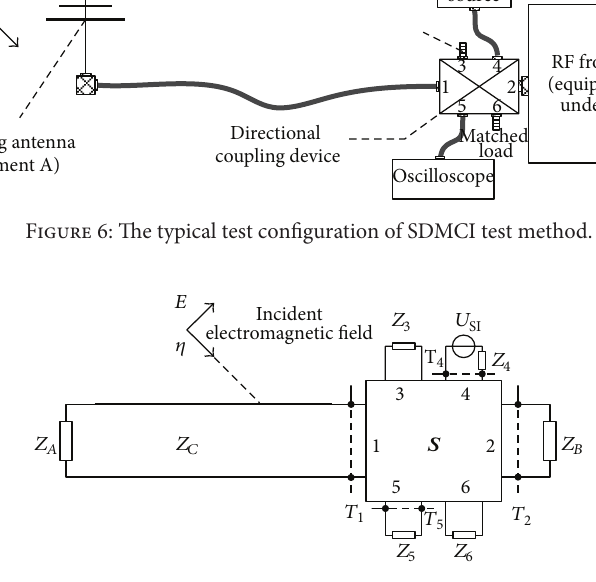
Figure 7: The equivalent circuit model when the DCD is inserted into the interconnected